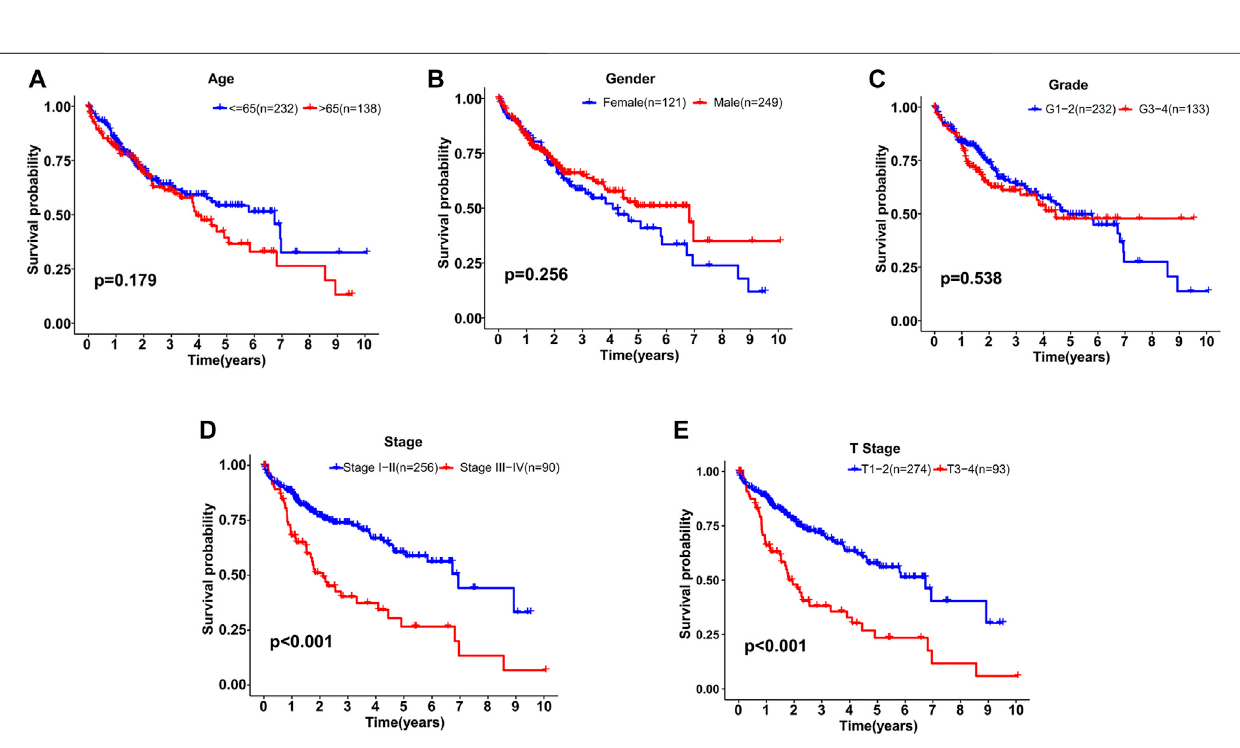
FIGURE 6 | Risk score distribution in different clinical subgroups. (A) Age. (B) Gender. (C) Grade. (D) Stage. (E) T stage. (F) N stage. (G) M stage.